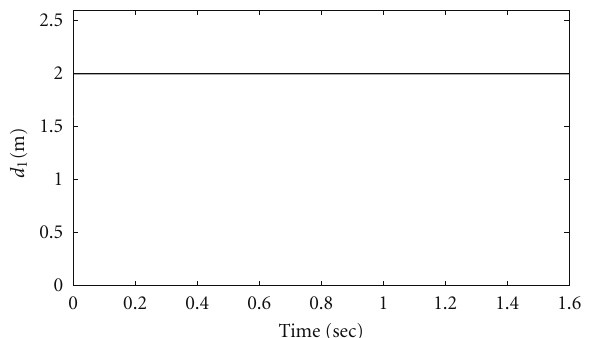
Figure 7: Plot of distance between leader and first follower versus time.